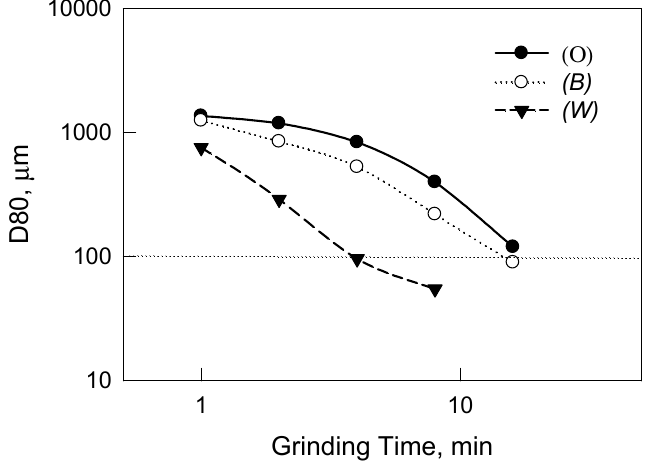
Figure 9. Median size (50% passing size) for various batch grinding times.